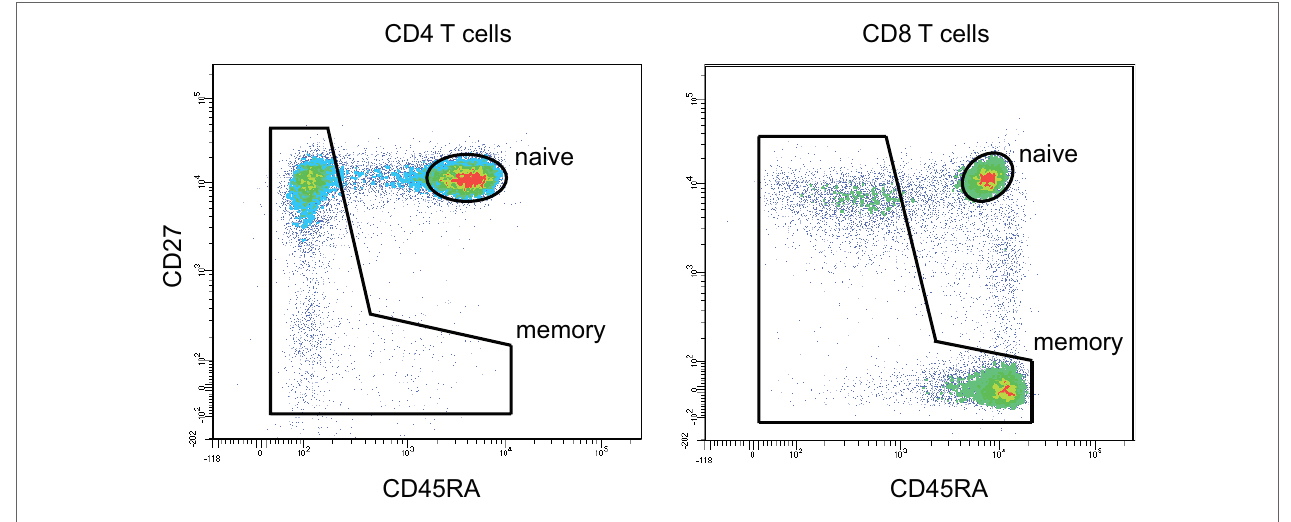
FigUre 1 | CD4 and CD8 naïve T cell gating strategy . Naïve CD4 T cells were gated as CD3 + CD4 + CD27 high CD45RA high . Naïve CD8 T cells were gated as CD3 + CD4 − CD27 high CD45RA high . 50,000 events were shown.